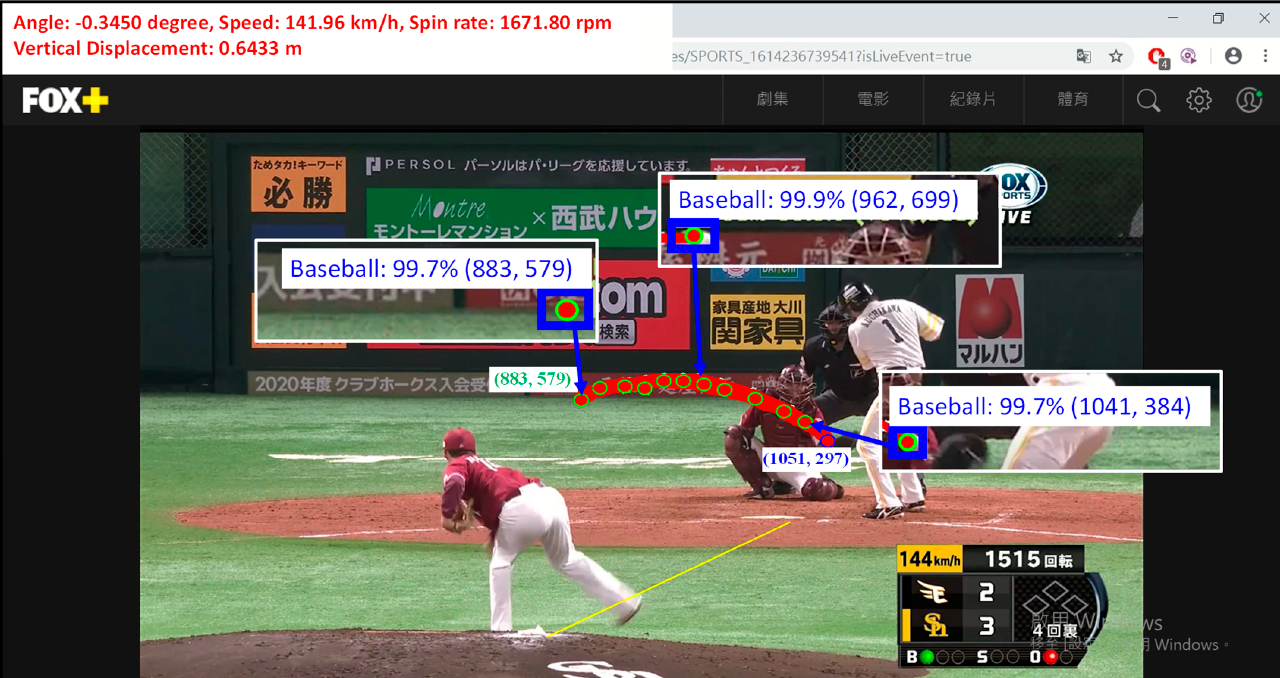
Figure 8. Automatic measurement result for a four-seam fastball.